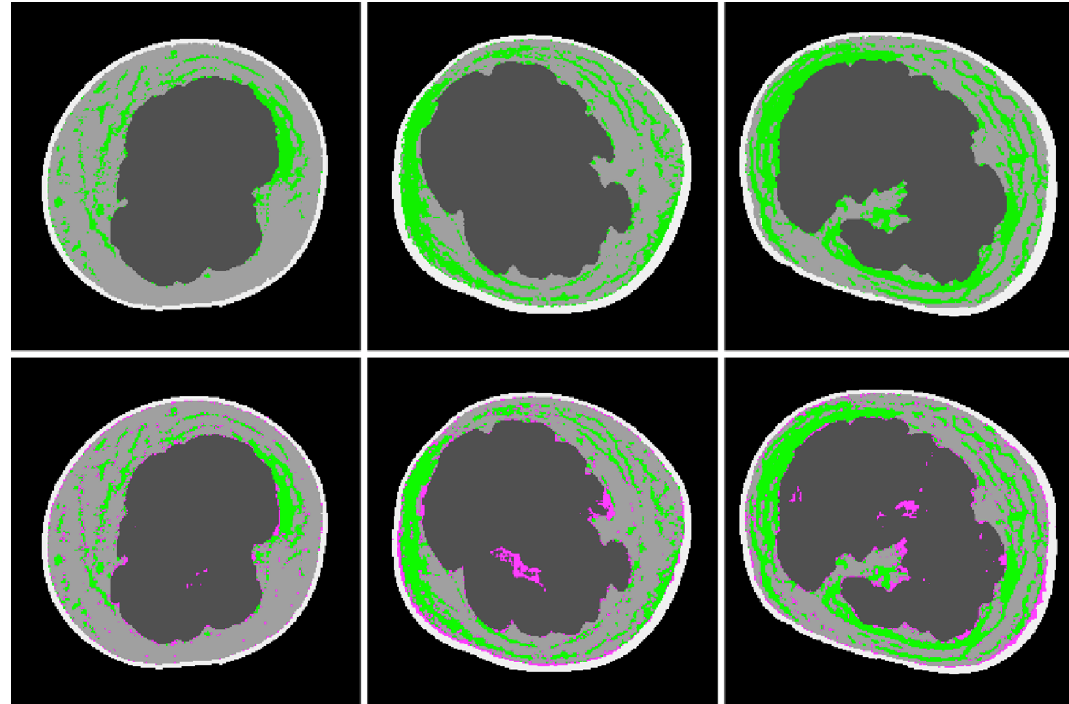
Figure 3. CT images (upper row) labeled using the lab-developed GUI and images classified using the trained algorithm (lower row). The pixels classified as fibrosis are marked in green, and the pixels incorrectly classified as fibrosis are marked in red. Partial correlation